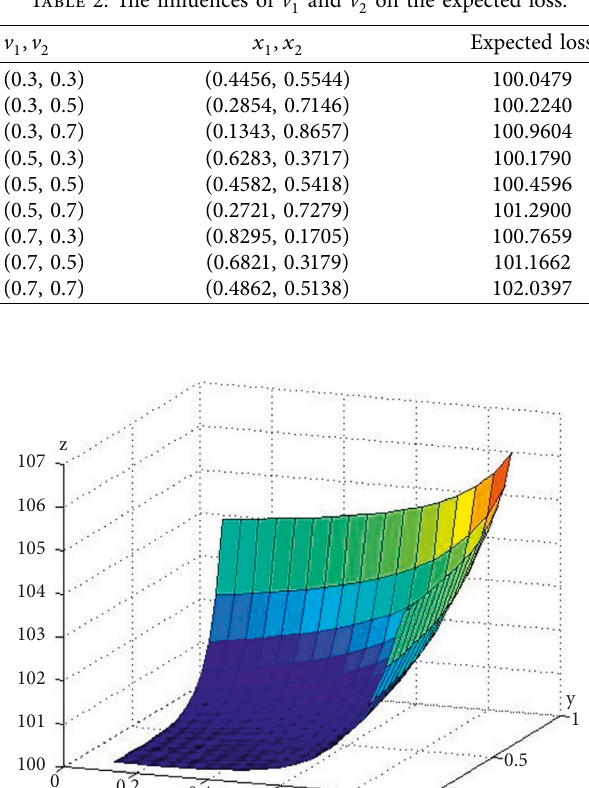
Table 2: The influences of v